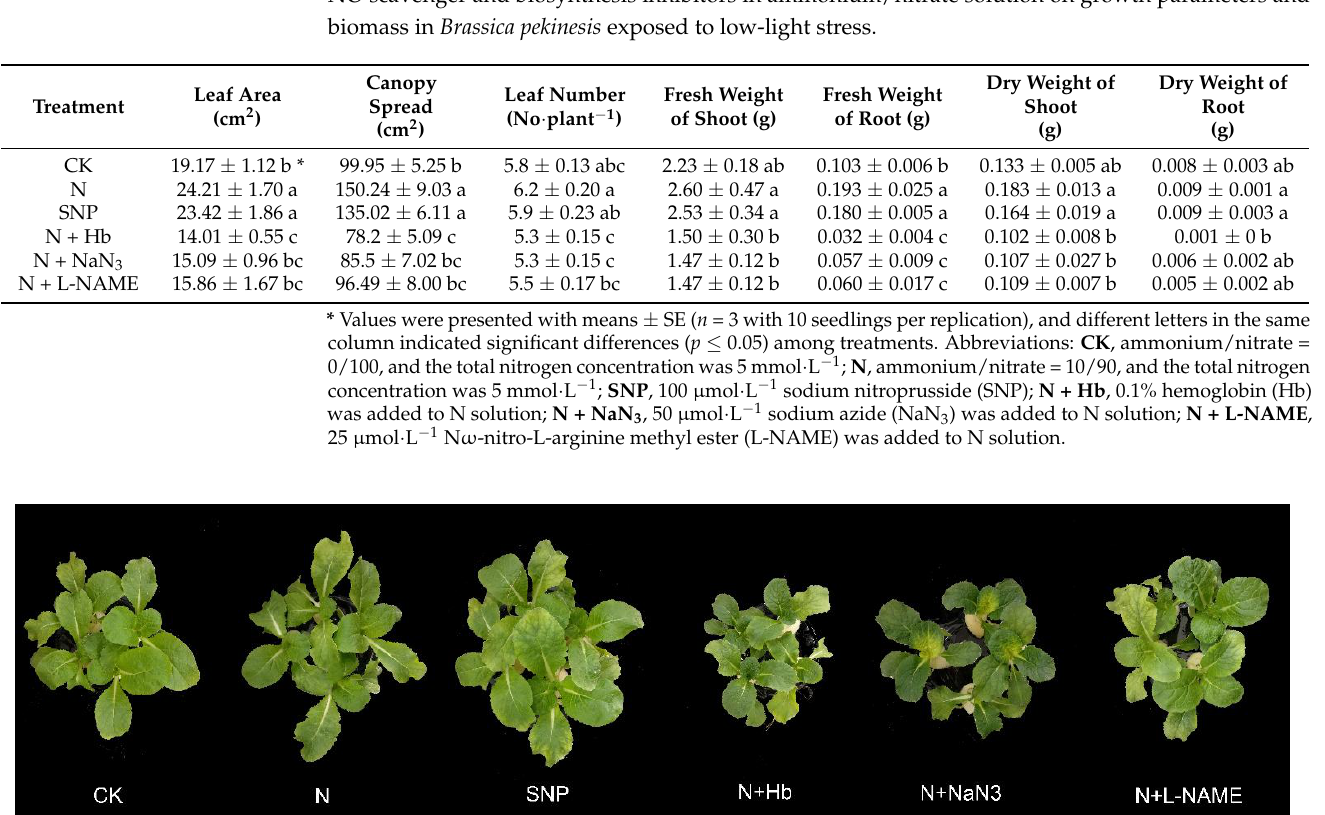
Table 1. Effects of exogenous nitric oxide, different ammonium/nitrate ratios, and the application of NO scavenger and biosynthesis inhibitors in ammonium/nitrate solution on growth parameters and biomass in Brassica pekinesis exposed to low-light stress.